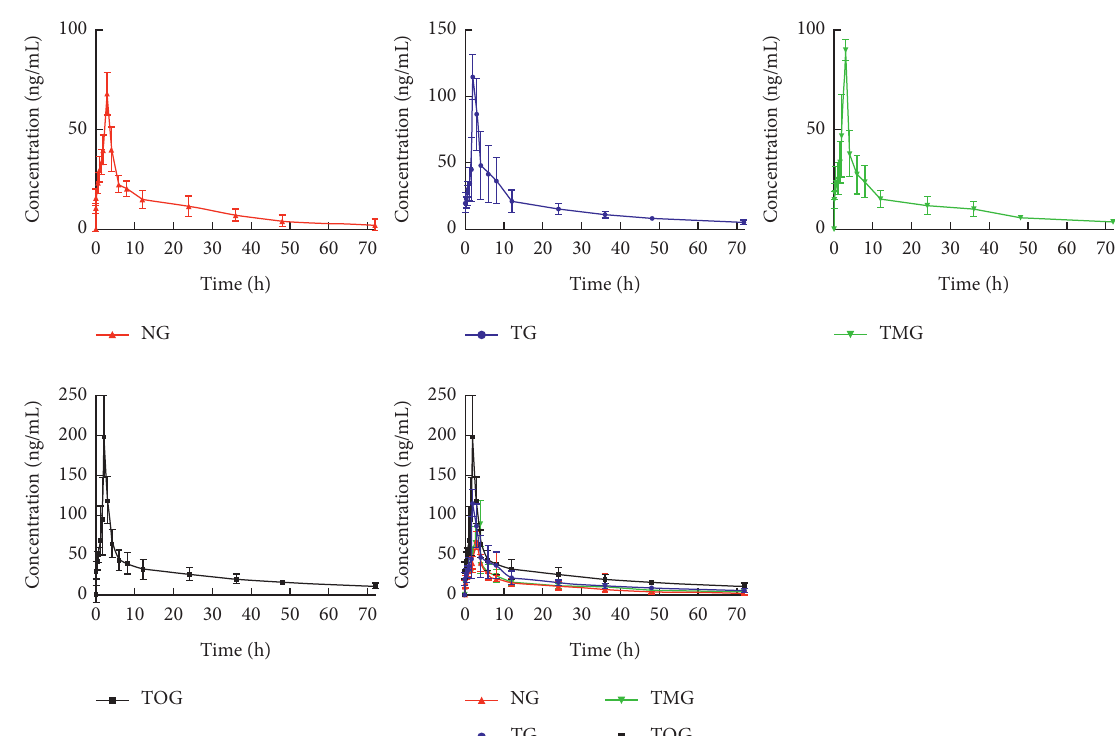
Figure 6: Mean plasma concentration-time profiles of TMEA after oral administration in rat of four groups ( n � 6). Normal group, TMEA group, TMEA-DMAG group, TMEA-DOMA group are abbreviated to NG, TG, TMG and TOG,